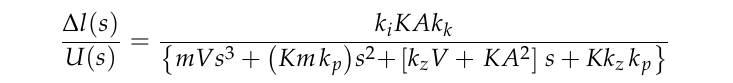
Figure 15. The final form of the closed-loop block diagram of the testing system.